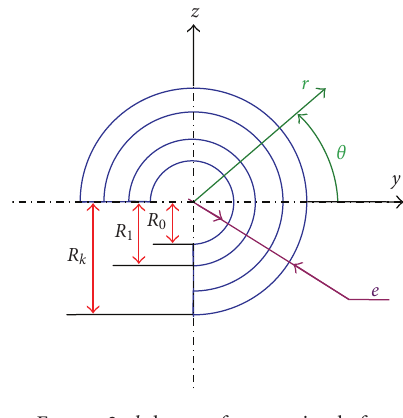
Figure 2: k -layers of composite shaft.